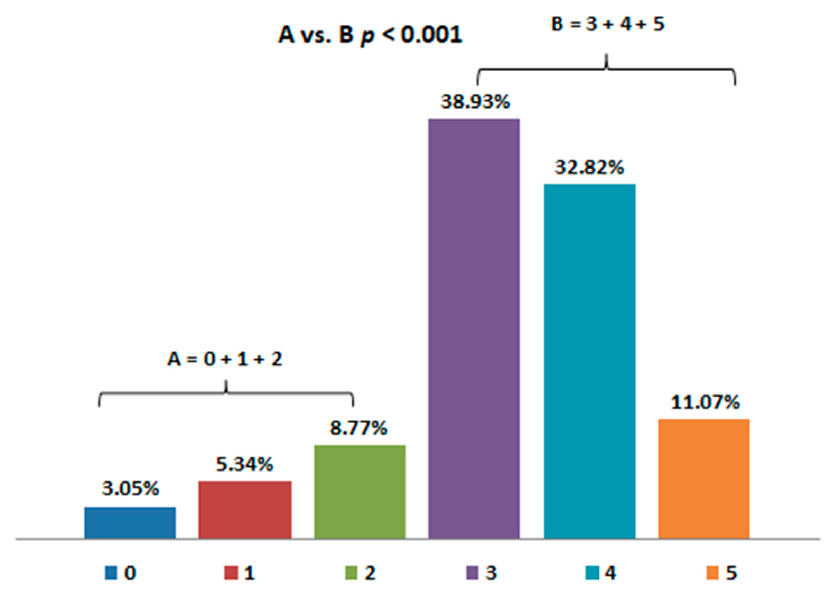
Figure 2. Patients’ self-assessment of knowledge about the impact of air pollution on health (from 0—lack of knowledge to 5—very extensive knowledge). The study group was divided into two sub- groups. Group A consisted of patients declaring lack of knowledge, very poor, and poor knowledge about the impact of pollution on health, while group B consisted of patients who declared good, very good, or excellent knowledge on this subject.